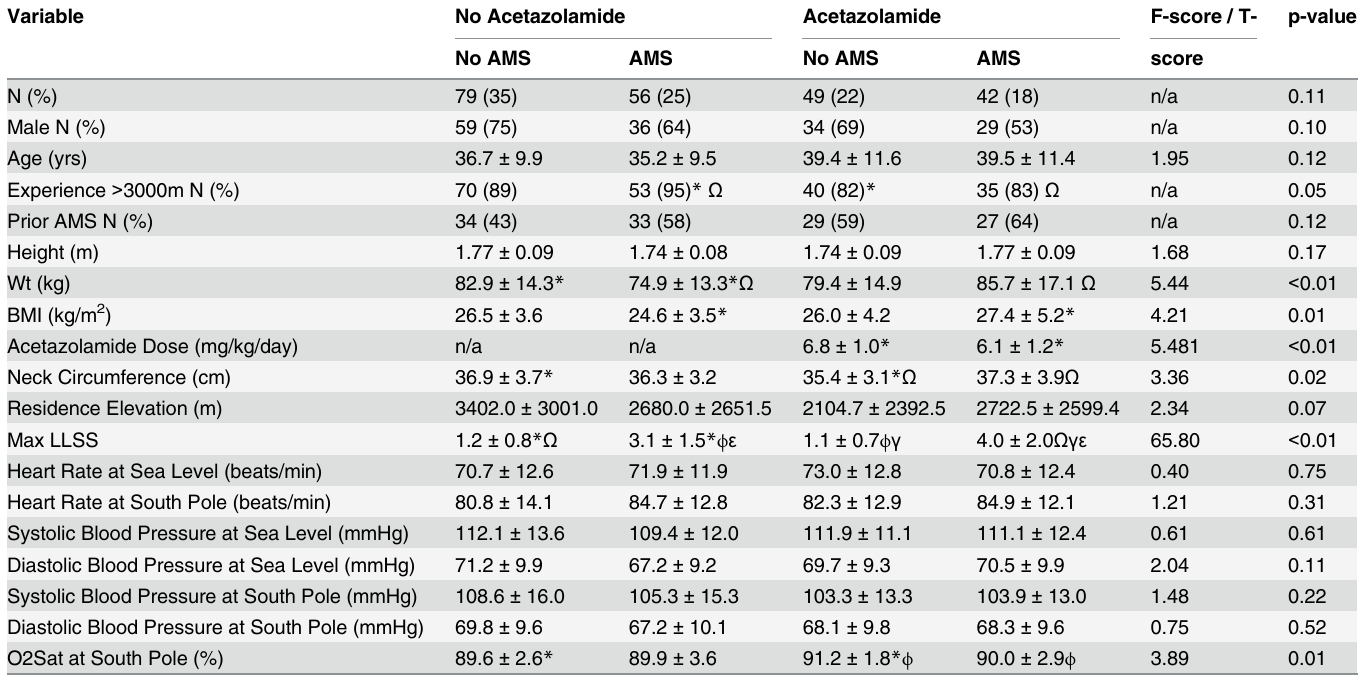
Table 1. Subject